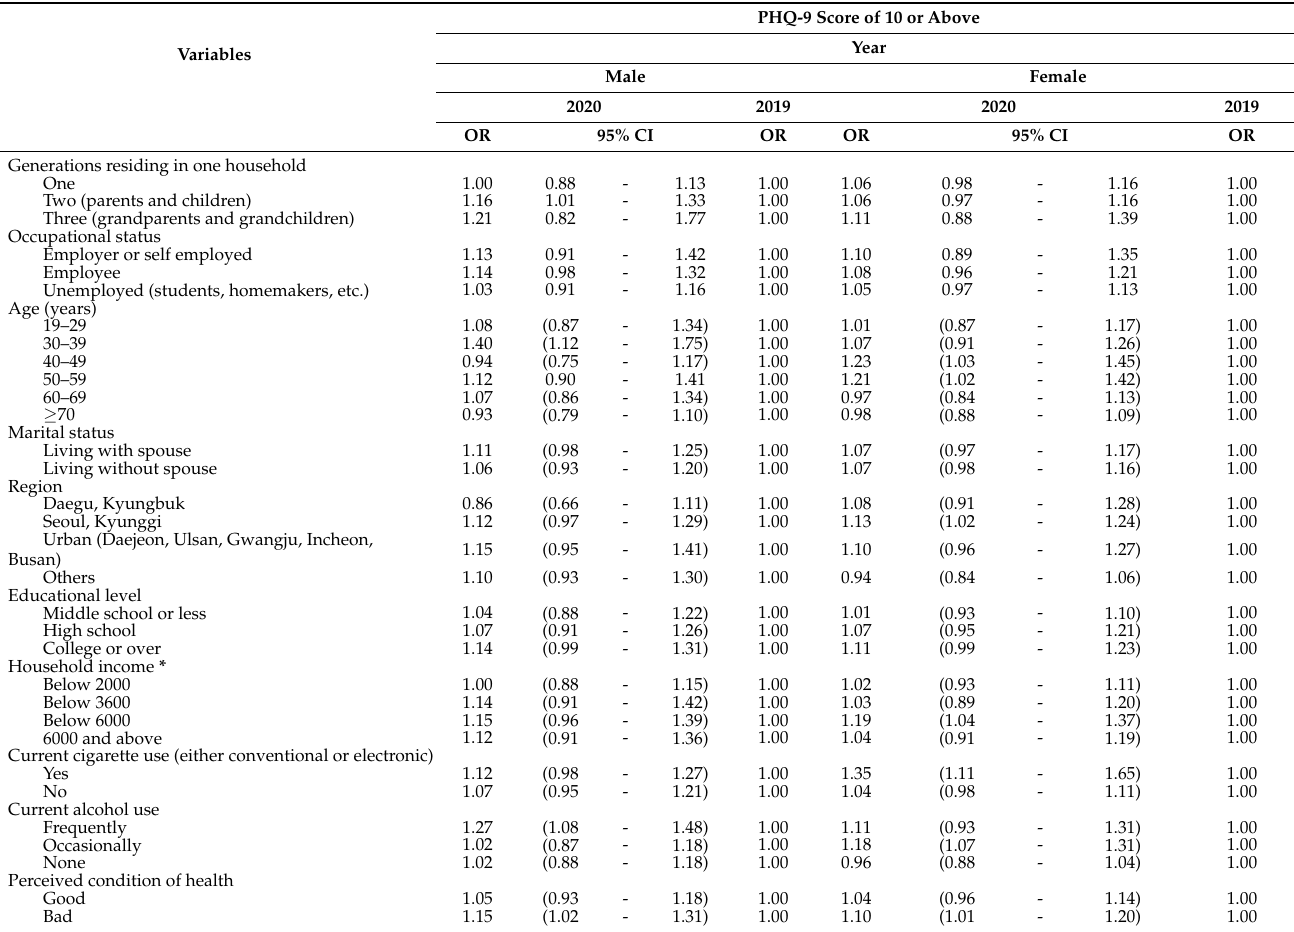
Table 3. The results of subgroup analysis stratified by independent